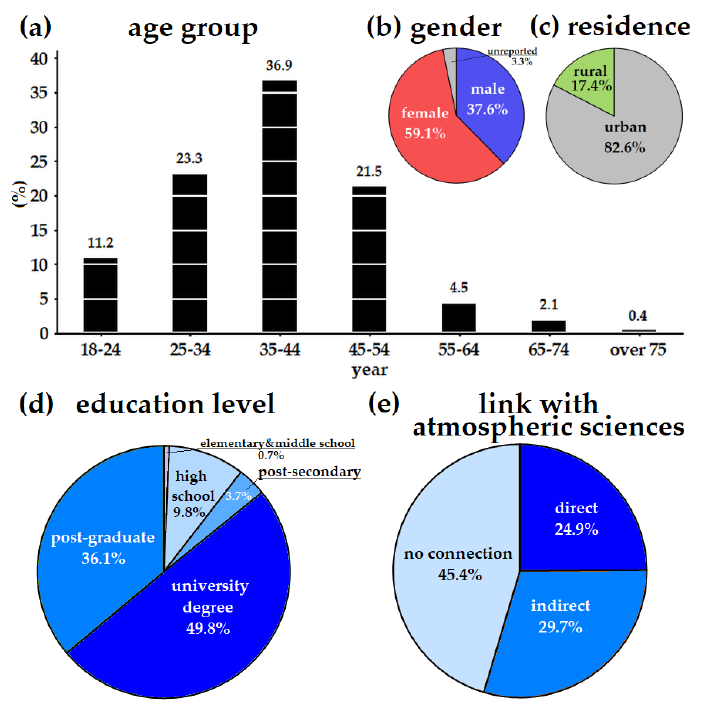
Figure A5. The summary of demographic profiles of the respondents (Q17 to Q21) regarding the age ( a ), gender ( b ), residence ( c ), education ( d ) and their connection with the atmospheric sciences ( e ).